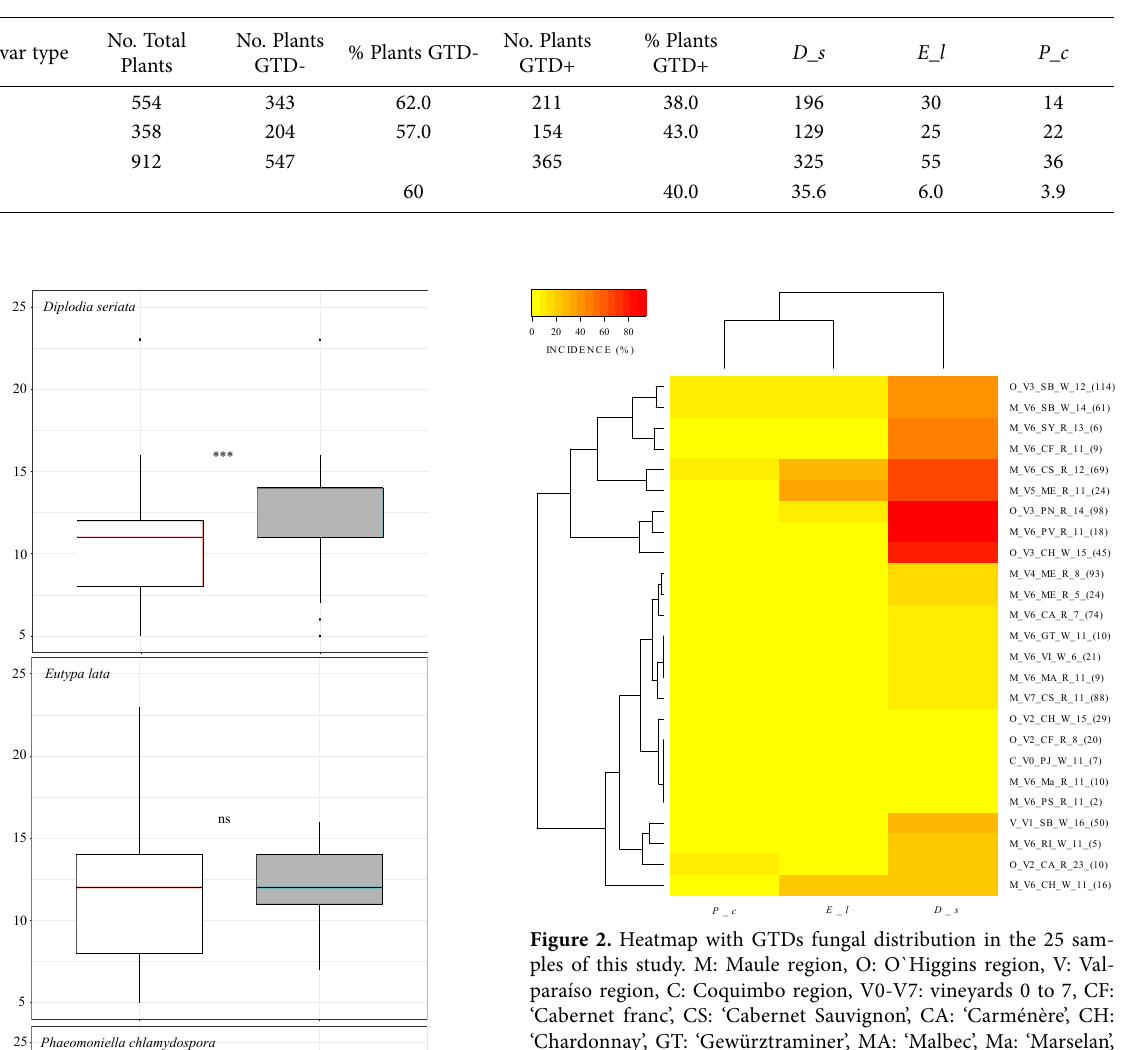
Table 5. Incidence of GTD pathogens by wine cultivar type. No. = number, GTD- = plants with no GTD fungi, GTD+ = plants with GTD fungi. D_s = Diplodia seriata , E_l = Eutypa lata and P_c = Phaeomoniella chlamydospora . The numbers below each fungus are the number of positive plants for that fungus.